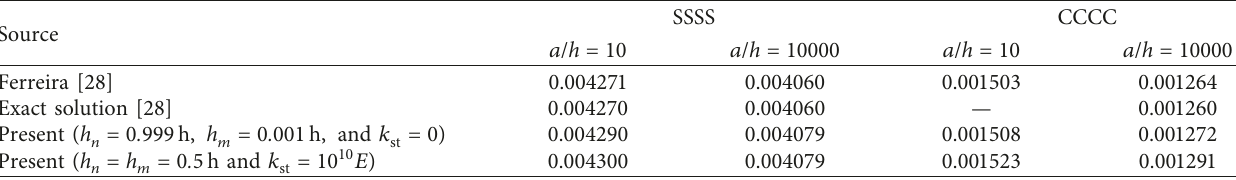
Table 1: Comparison of nondimensional deflection of square plates with a / h � 10 and a / h � 10000.